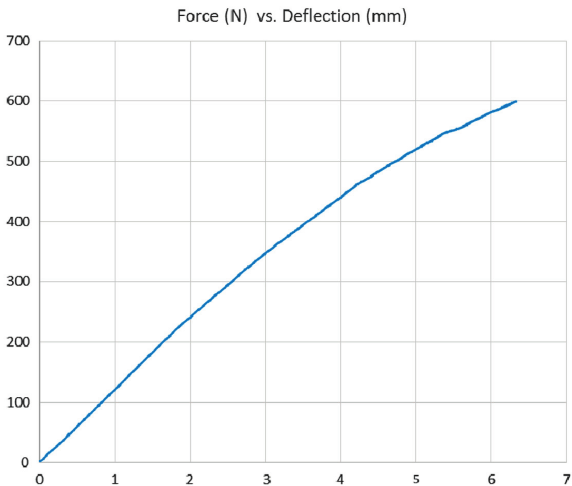
Figure 6. Force-deflection diagram of the shear force load (in N) plotted as a function of end deflection (in mm) of the Schanz screws inserted in the ONAS-DPS. The distance between the point force load and the fixation of the specimen was 60